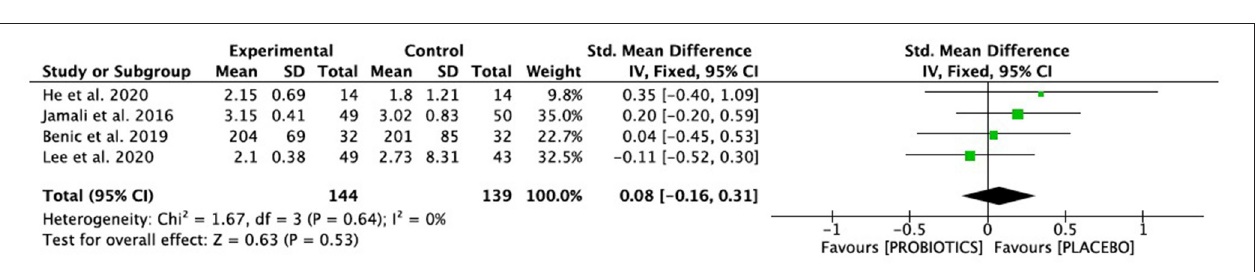
FIGURE 4 | Forest Plot of the effectiveness on halitosis of probiotic vs. placebo, in a fixed effects model. SD, Standard Deviation, CI, Confidence